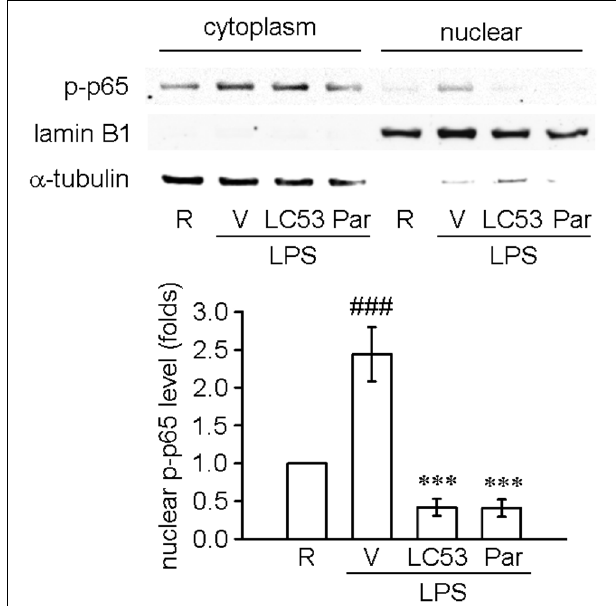
FIGURE 7 | LC53 inhibited the nuclear phosphorylated p65 translocation in LPS-stimulated microglial BV2 cells. Microglial BV2 cells were pretreated with the vehicle (DMSO), LC53 (10 µ M) or parthenolide (10 µ M) and stimulated with LPS (150 ng/ml) for 30 min. Phosphorylated p65 levels in both cytoplasm and nuclear of BV2 microglia were examined using Western blot. The detections of α -tubulin and lamin B1 were used as the internal control for cytoplasm and nucleus ( n = 4). R, resting; V, vehicle (DMSO); Par, parthenolide; p-p65, phosphorylated p65. ### p < 0.001 compared with the resting group; ∗∗∗ p < 0.001 compared with the LPS-stimulated group treated with